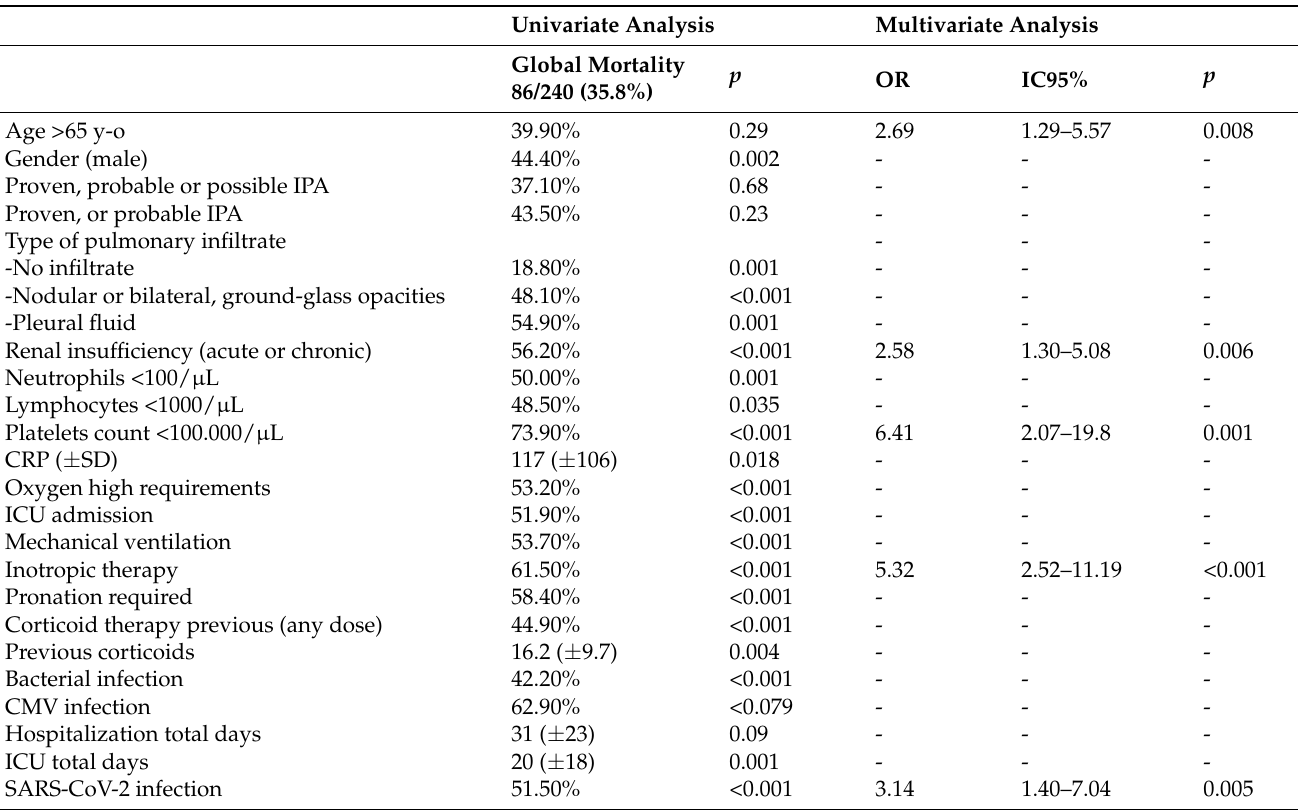
Table 2. Analysis of mortality. Uni- and multivariate analysis including all patients. Univariate Analysis Multivariate Analysis Global Mortality p OR